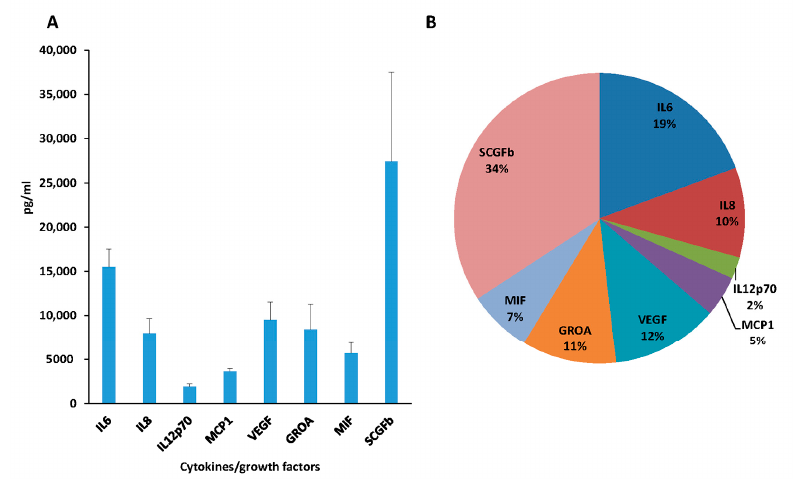
Figure 3. MSCs secretome analysis. ( A ) The histogram reports eight cytokines/growth factors mea- sured in MSC-conditioned media (expressed in pg/mL). Each point represents the mean ± standard error (SEM) of the determinations performed on nine different MSCs donors. ( B ) Cytokines/growth factors expressed as percentage calculated on the total amount of the eight molecules.